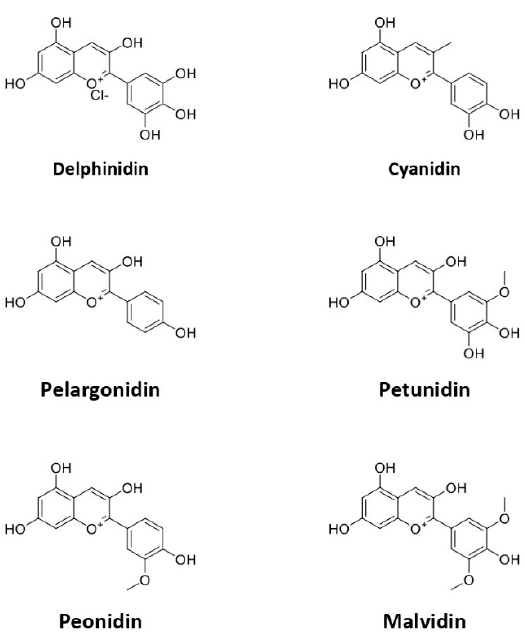
Figure 2. The chemical structure of subtypes of